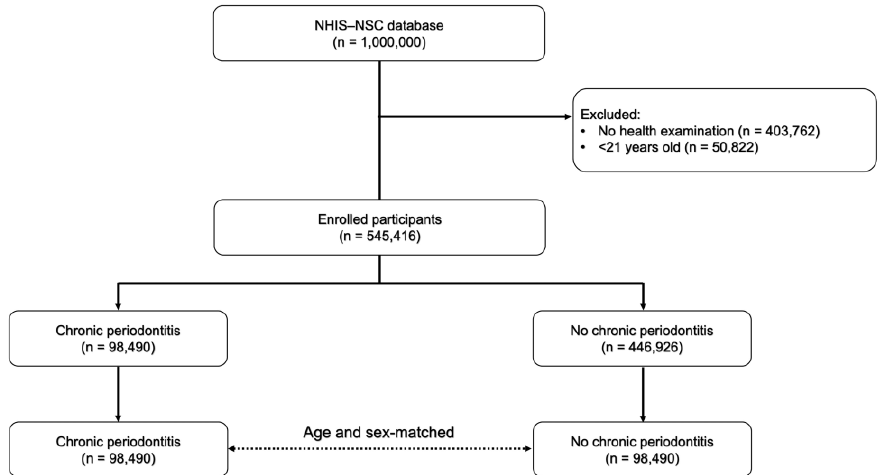
Figure 1. Flowchart of the inclusion and exclusion criteria for the study participants, NHIS-NSC, National Health Insurance Service — National Sample Cohort.